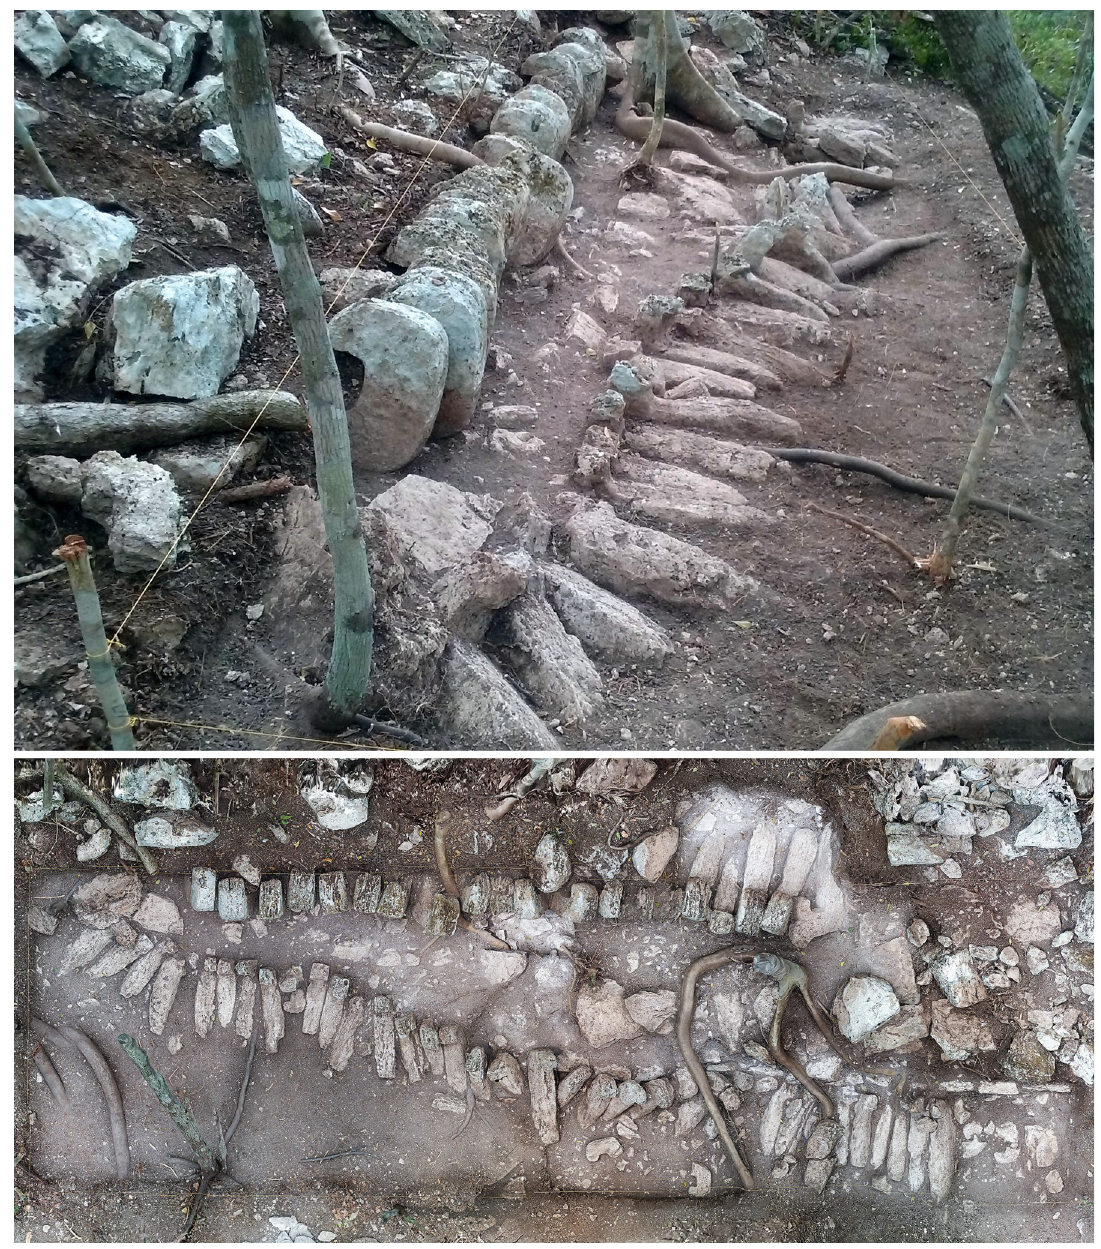
Fig 10. Array of fang-like stones on the north side of the main structure of group G33-a, looking west (top) and from above (bottom). 2 m and are up to 0.5 m thick, whereas quadrangular altars are up to 2.2 m long, 1.3 m wide and 0.5 m thick. Several quadrangular altars have cylindrical stone supports (Fig 11A and 11B), representing a regional peculiarity first observed in the case of Altar 1 of Lagunita [33]. While most of these monuments are plain, CHRP Stela 1, found in the plaza of group F15-b, features a local dignitary on the front and a few pseudo-glyphs on its sides (Fig 11C). CHRP Altar 1, a quadrangular monument on four cylindrical supports, with a richly clad local lord on its upper surface and with an inscription on its sides, was found in the plaza of group I14-c,